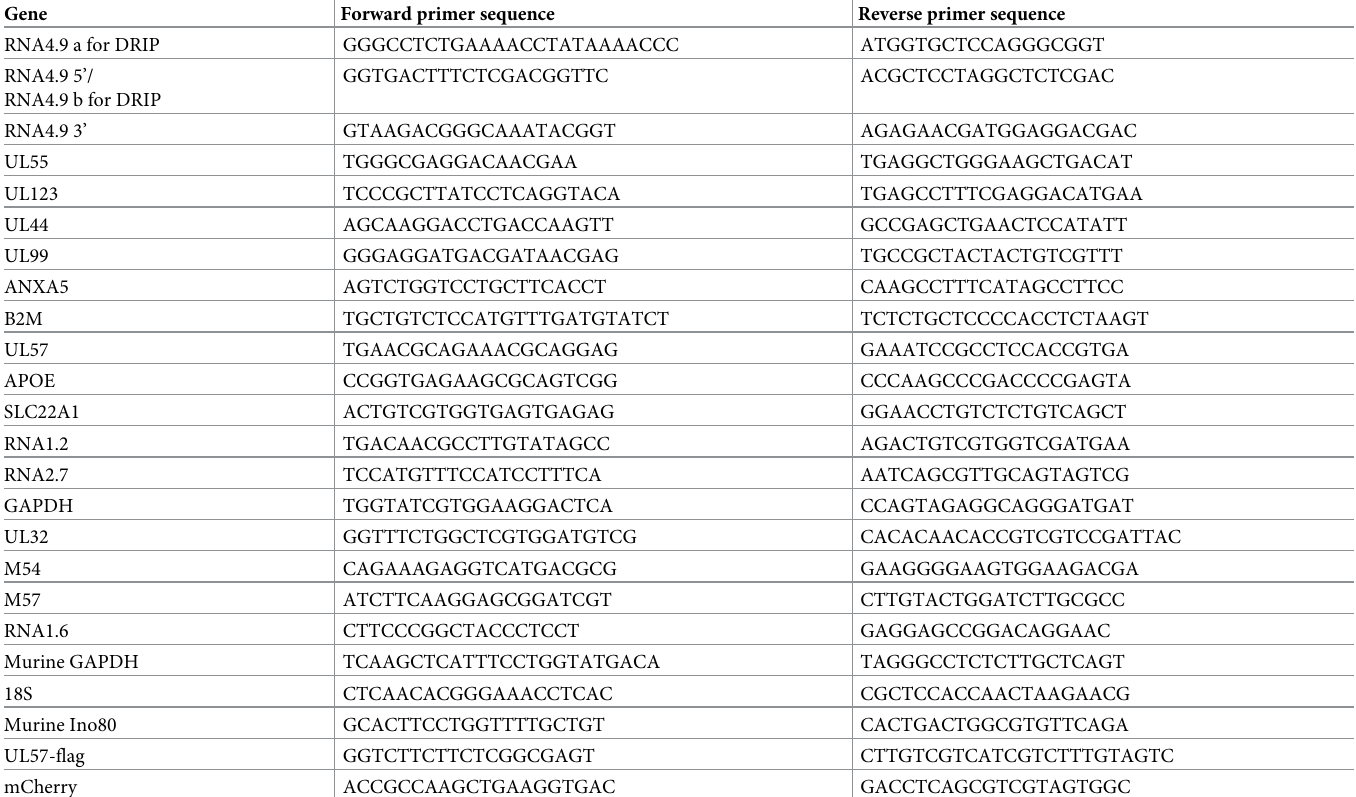
Table 2. Primer sequences used for real-time PCR. Gene Forward primer sequence Reverse primer sequence RNA4.9 a for